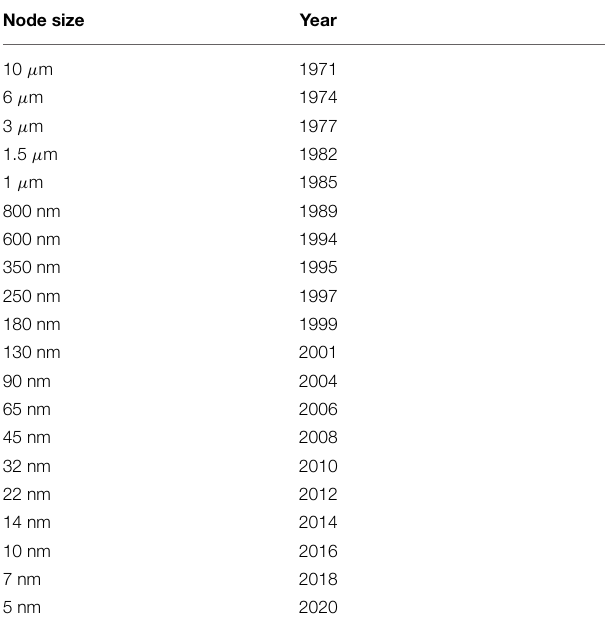
TABLE 1 | Node size and first year of commercial introduction for CMOS